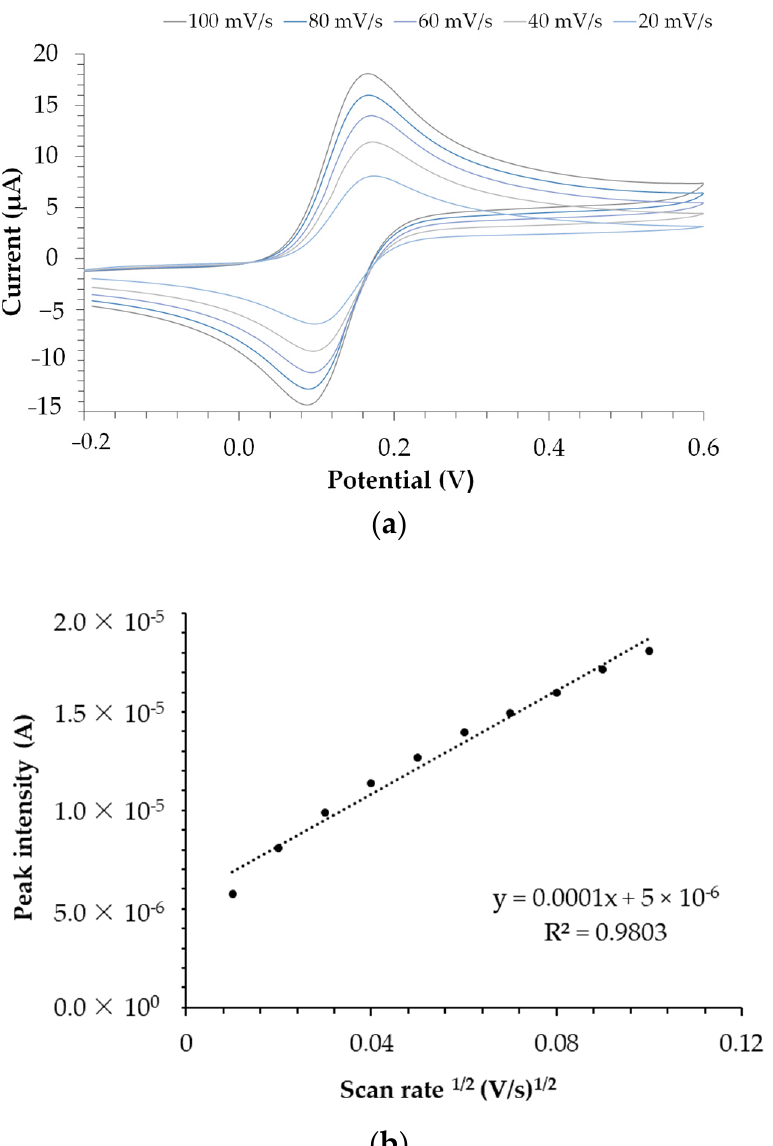
Figure 5. Active area calculation for the gold commercial-based electrode: ( a ) Cyclic voltammetry with 1 mM K 4 Fe(CN) 6 in 0.1 M KCl with a scan rate from 100 to 10 mV s − 1 ; ( b ) Randles Equation linear regression.